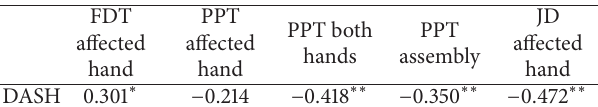
Table 5: Correlations between FDT, PPT, and JD scores and DASH scores in TF